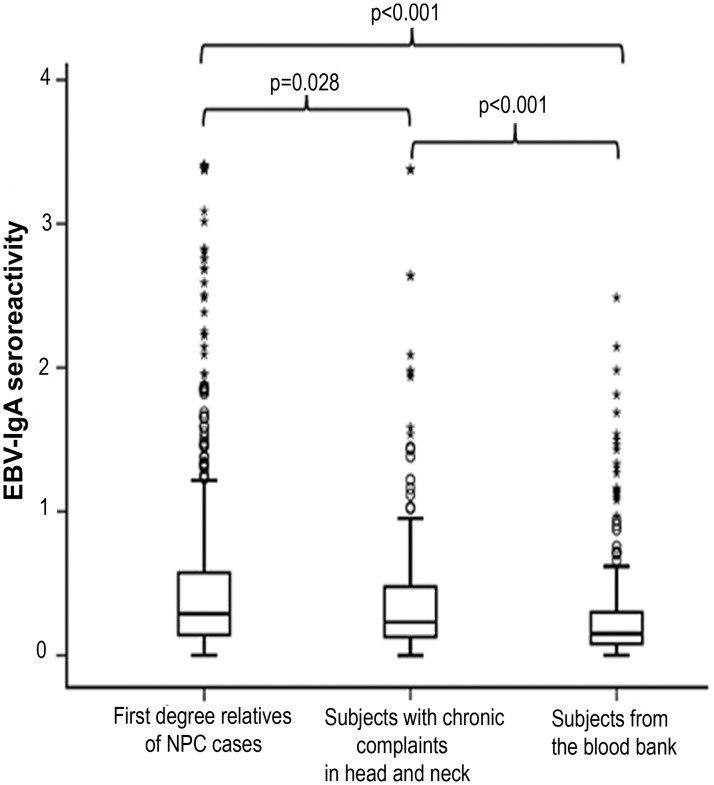
Boxplot of normalised EBV-IgA ELISA seroreactivity by groups.Seroprevalence was shown by 41.7% of family members of NPC cases, compared to 32.7% of individuals with chronic problems in the head and neck area and 16.4% of individuals recruited from the blood bank (Pearson’s χ2 test p< 0.001). A significant difference in seroprevalence was also found between NPC family members and patients with chronic diseases (p = 0.028). Extreme and mild outliers were represented by symbols of * and °.